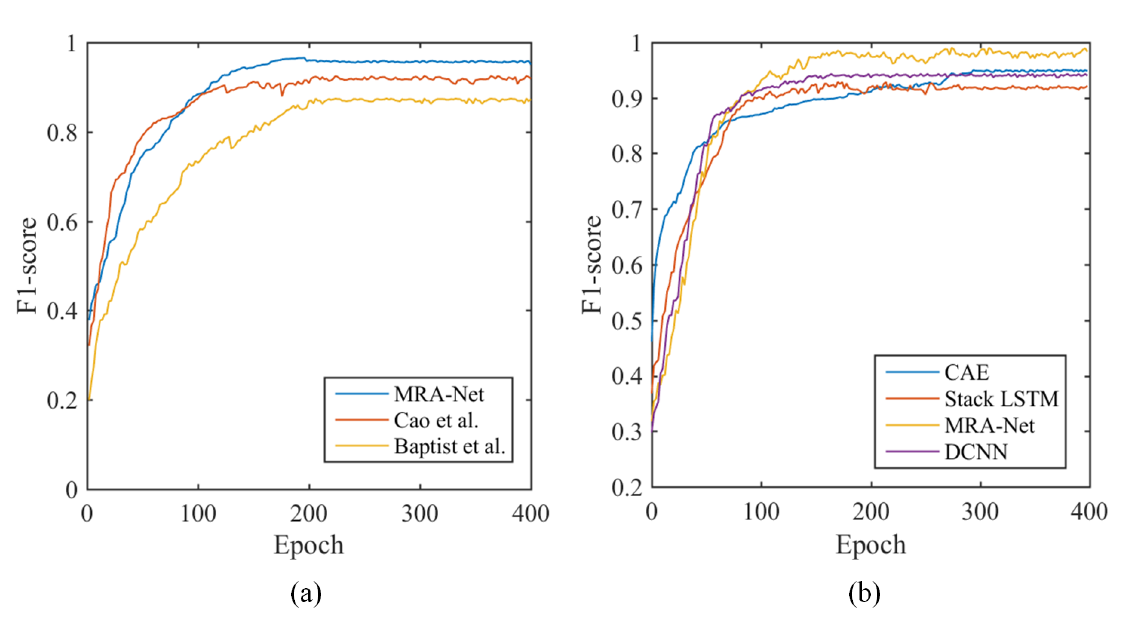
Figure 10. ( a ) Performance comparison for person identification on test dataset. ( b ) Performance comparison for activity recognition on test dataset. The proposed MRA-Net for joint activity recognition and person identification outperforms the state-of-the-art single-task